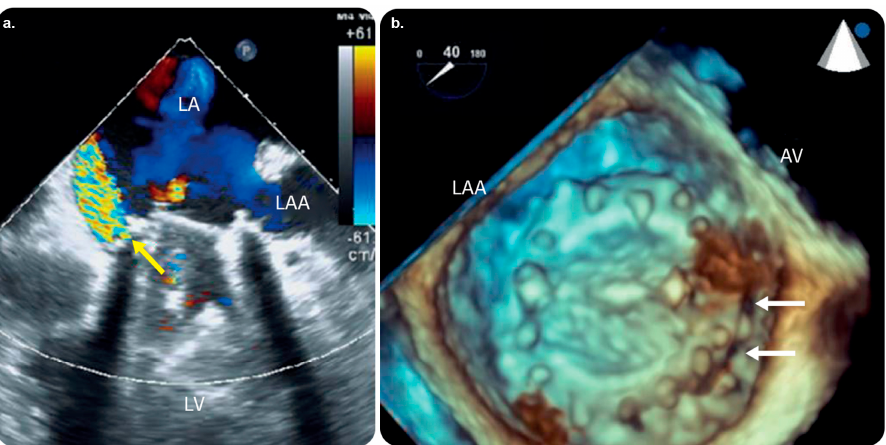
Figure 12. EchoNavigator software and its role in intuitive display. Preprocedural TEE. ( a ) 2D TEE color Doppler image showing severe paravalvular leakage (yellow arrow). ( b ) 3D TEE image showing dark holes between the prosthetic mitral valve and mitral annulus (white arrows) localized at the medial side of the anterior mitral annulus near the aortic valve. Abbreviations: AV, aortic valve; 3D, three-dimensional; 2D, two-dimensional; LA, left atrium; LAA, left atrial appendage; LV, left ventricle; TEE, transesophageal echocardiography. Reprinted from “Three-dimensional EchoNavigator system guided transcatheter closure of paravalvular leakage” by Kim et al. [70] with permission from the corresponding author and the publisher (Journal of Cardiovascular Imaging; Copyright 2019 [open access license]).